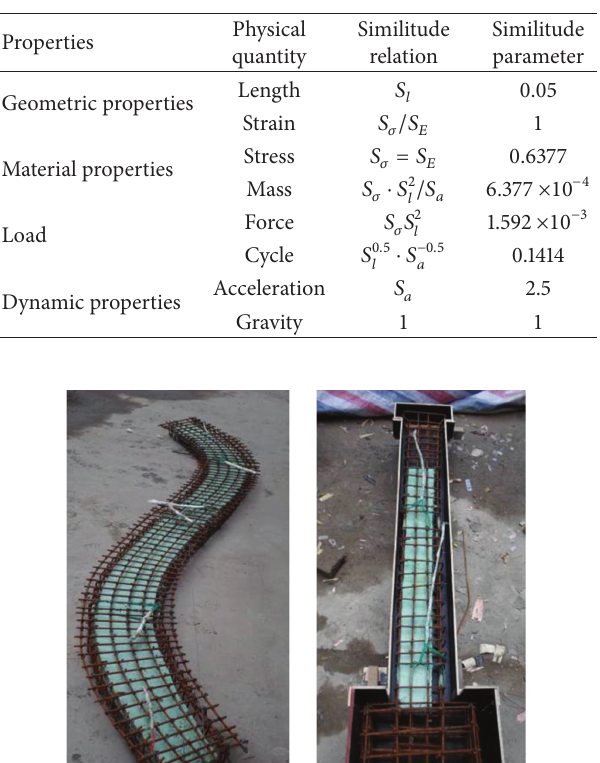
Table 1: Similar constants.